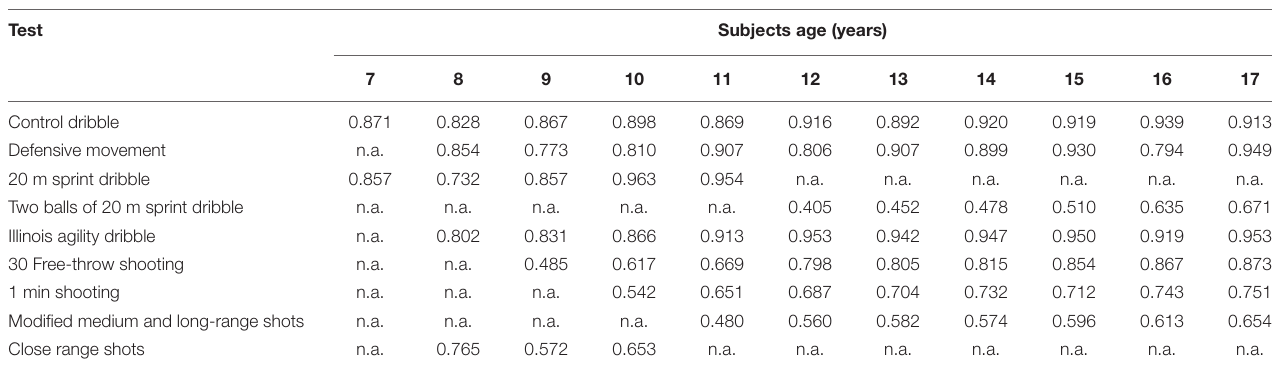
TABLE 3 | Technical fitness test